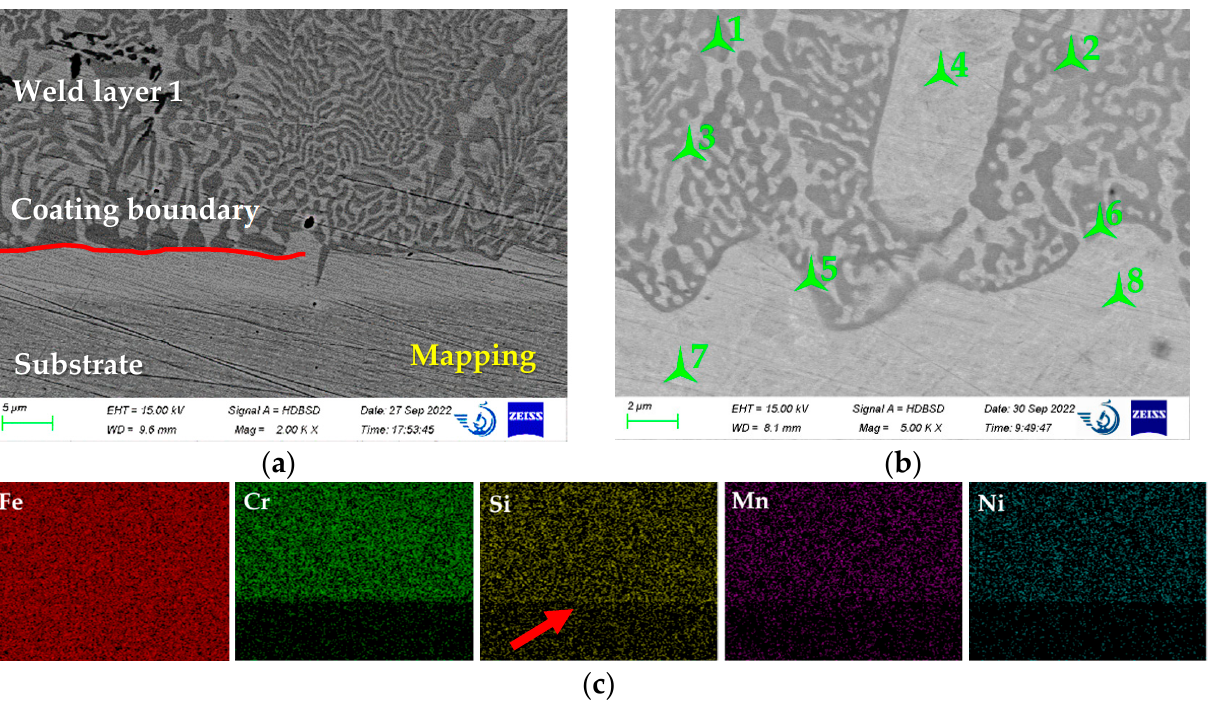
Figure 4. The structure of the obtained coating and EDS mapping of the substrate–coating interface: ( a ) general layout, ( b ) points location for the EDS point analyses, and ( c ) EDS maps of the coating–substrate interface. Table 2. The results of EDS point analyses of the coating